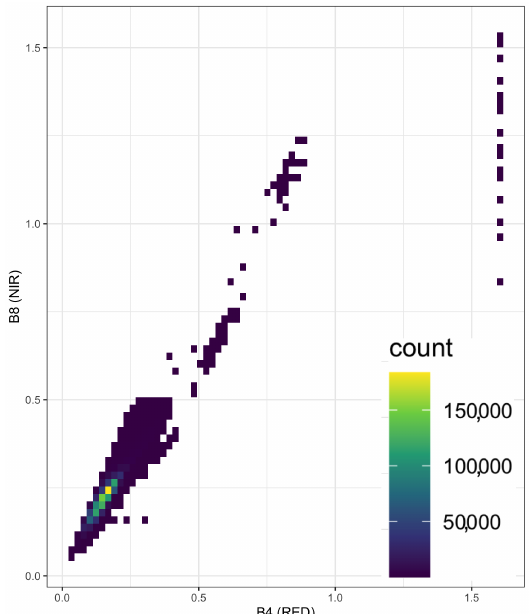
Figure 8. The RED-NIR scatter (shown in a density plot) of Sentinel-2 pixels of agricultural parcels with NDVI < 0.3 (data acquisition is 20 April 2020—Rank 1).